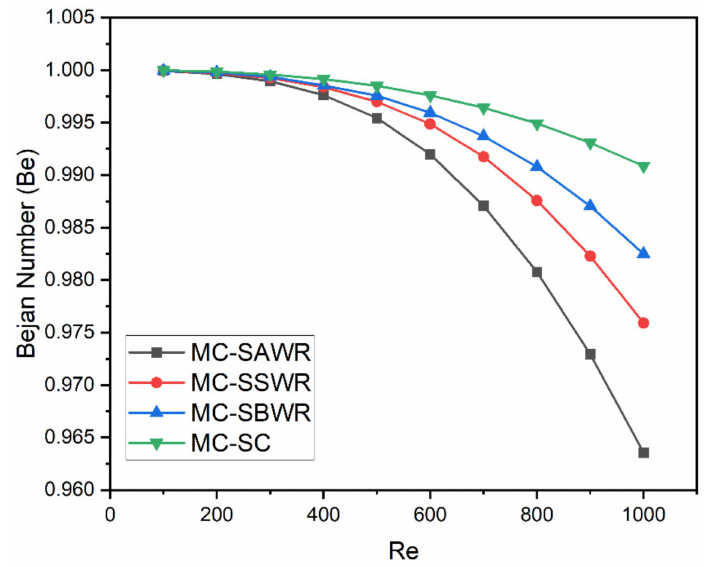
Figure 19. Variation of Bejan number ( Be ) with Re for various MCHS configurations.